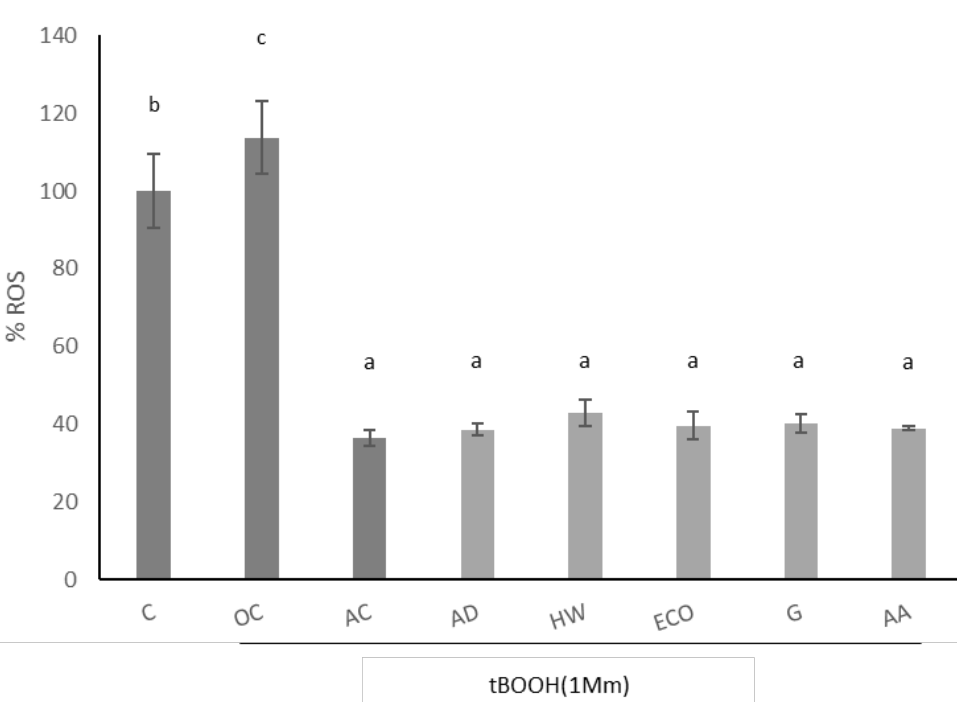
Figure 3. Effect of aqueous extracts obtained from different kiwi fruits (1 mg/mL) on induced ROS of IEC-6 intestinal cells. C: control — untreated cells; OC: oxidation control — tBOOH (1 mM); AC: antioxidant control —vitamin C (10 μg/mL); AD: A. deliciosa ; HW: A. deliciosa var. Hayward; ECO : A. deliciosa var Hayard eco; G: A. chinensis ; AA: A. arguta . Data are shown as the mean ± SD of three independent experiments. Different letters above columns indicate significant differences among treatments (Duncan test, p ≤ 0.05). Different shadow color has been used to differentiate controls and samples.